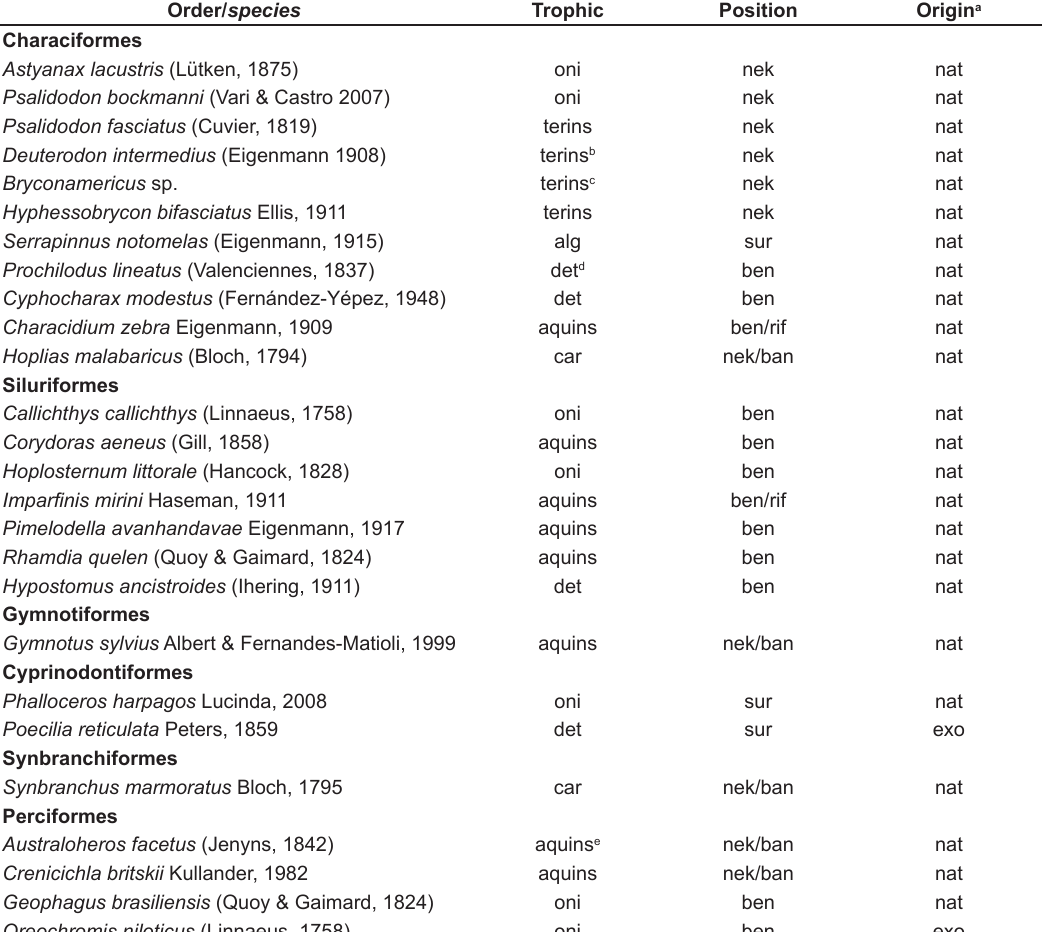
Table 2. Classification of sampled species according to attributes related to trophic group (alg, algivores; aquins, insectivores with predominance of aquatic forms; car, carnivores; det, detritivores; oni, omnivores; terins, insectivores with predominance of terrestrial forms), position in the water column (ben, benthic; ben/rif, benthic associated with riffles; nek, nekton; nek/bank, nekton associated with stream banks; sur, close to the surface of the water) and origin in the Upper Paraná River system (nat, natives; exo,